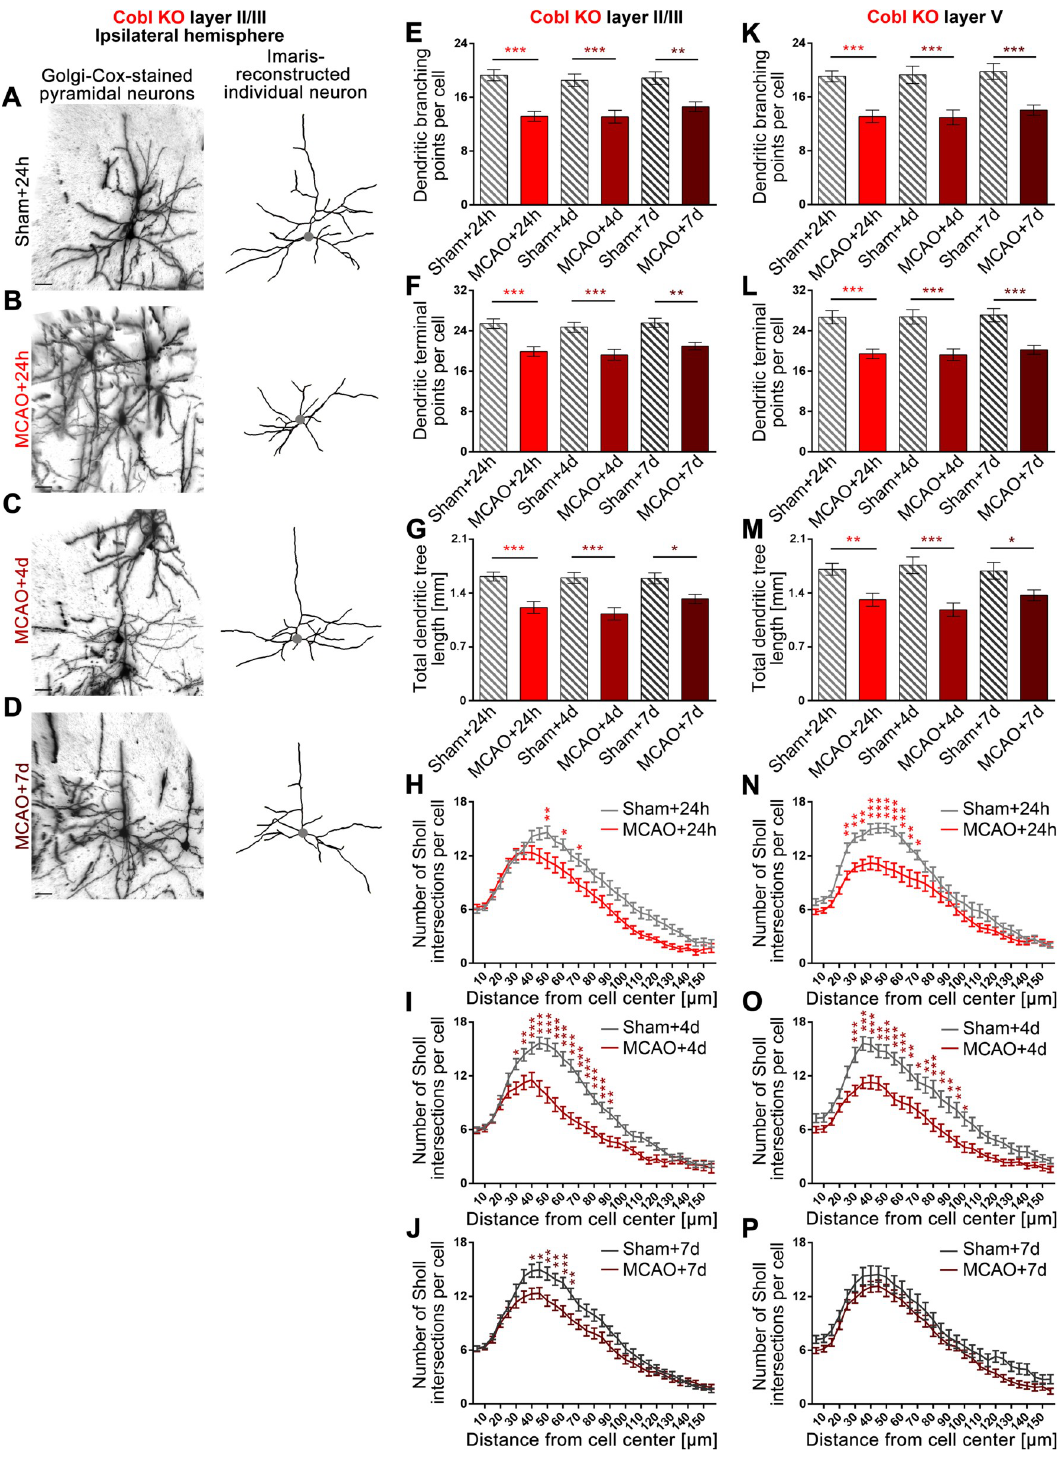
Fig 7. Cobl KO mice fail to show repair of the dendritic arborization defects caused by MCAO in both layer II/III and layer V neurons of the ipsilateral hemisphere. A–D , Representative images of Golgi–Cox-stained and Imaris-reconstructed ipsilateral layer II/III pyramidal neurons of M1 of Cobl KO mice subjected to sham surgery and of Cobl KO mice subjected to 30-minute MCAO at 24 hours, 4 days, and 7 days of reperfusion time. The position of the cell bodies are marked by a gray dot. Scale bars, 30 μ m. E–J , Quantitative determinations of dendritic arborization parameters of layer II/III neurons. Note that dendritic branching points ( E ),